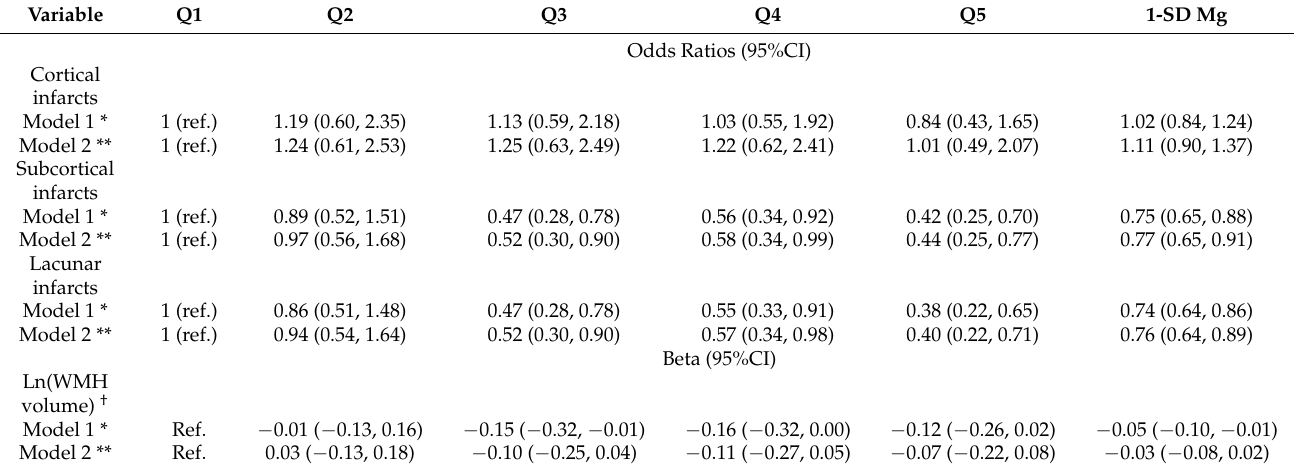
Table 3. Associations of serum magnesium with markers of cerebrovascular disease, ARIC-NCS 2011–2013.